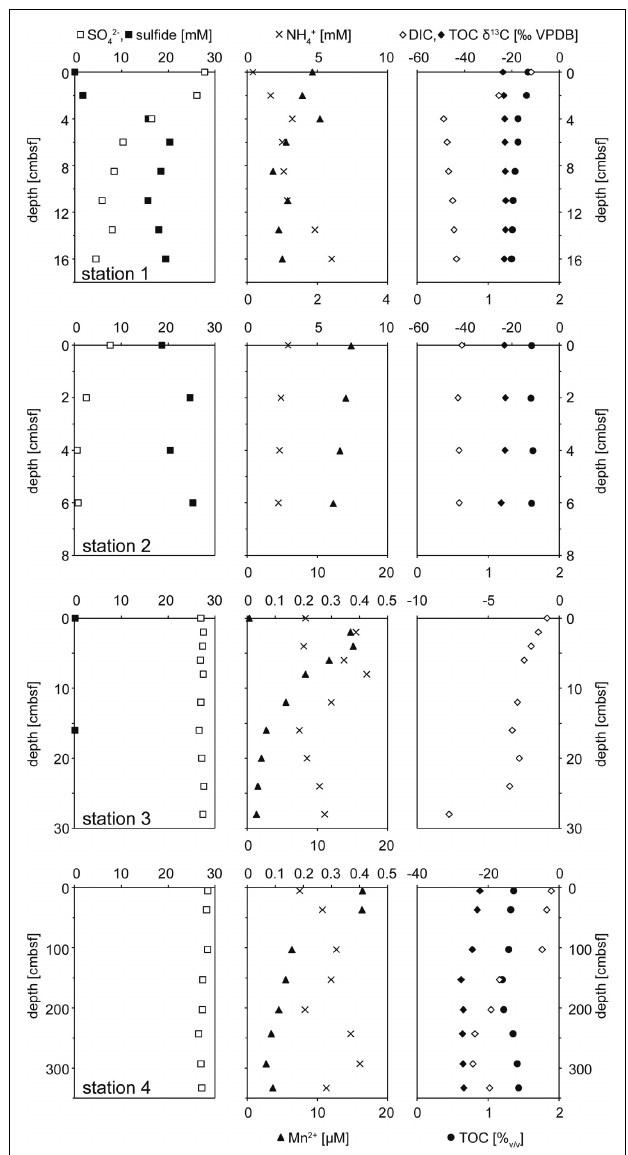
FIGURE 3 | Geochemical profiles of stations 1 – 4. Stations 1 and 2 comprised ANME rich sediments actively performing AOM.The left panel shows sulfate ( (cid:2) ) and sulfide ( (cid:3) ) profiles.When sulfide concentrations were below the detection limit of 0.1 they are not sown.The central panel depicts dissolved manganese ( (cid:4) ) and ammonium ( × ). δ 13 C isotopic compositions of DIC ( (cid:3) ) andTOC ( (cid:5) ) are displayed on the right.The concentration ofTOC ( • ) in the dry mass is given in (%).